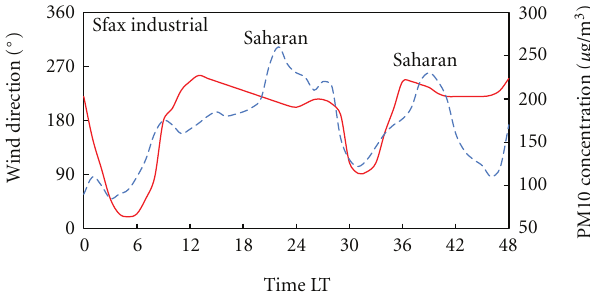
Figure 9: Time series plots of wind direction and PM10 concen- trations during a Saharan dust sample period in Sfax’s site. Time evolution of the left y axis is plotted with solid line, and the right one is plotted with dashed line. (Solid and dashed lines are smooth curve